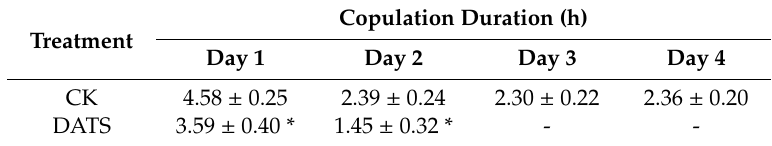
Table 2. E ff ect of diallyl trisulfide (DATS) on the copulation duration of Sitotroga cerealella . Copulation Duration (h) Treatment